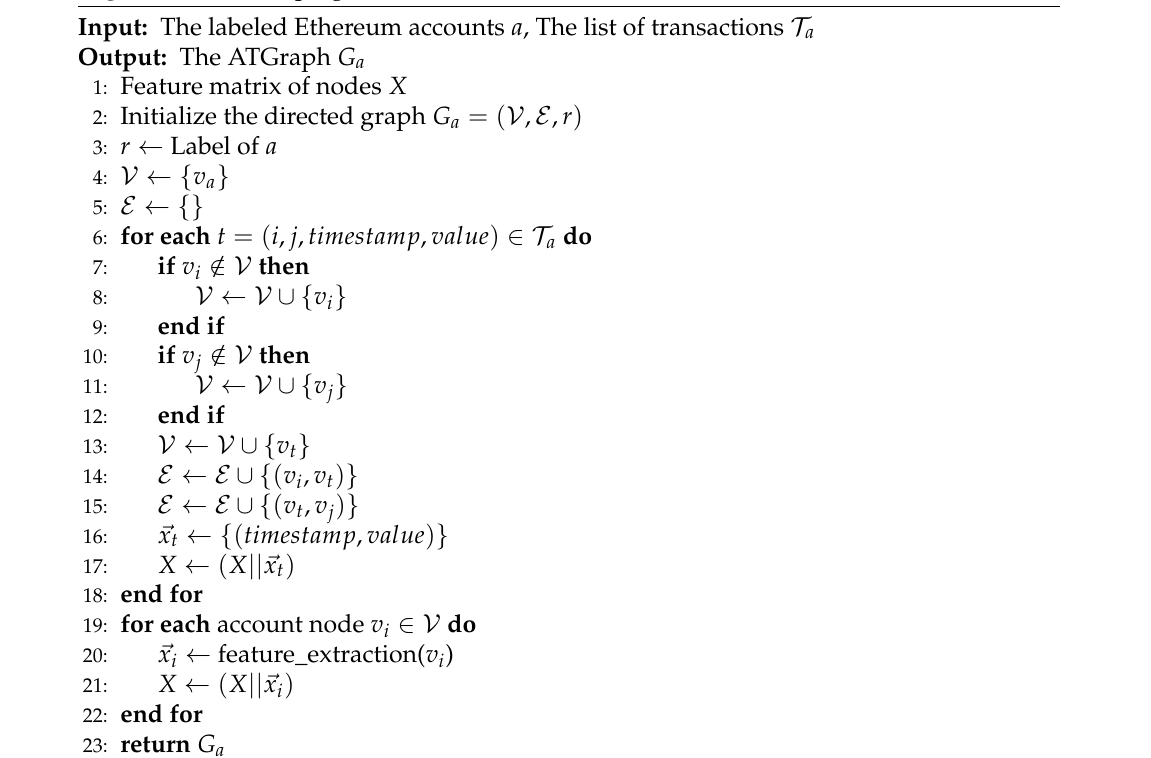
Algorithm 1 ATGraph